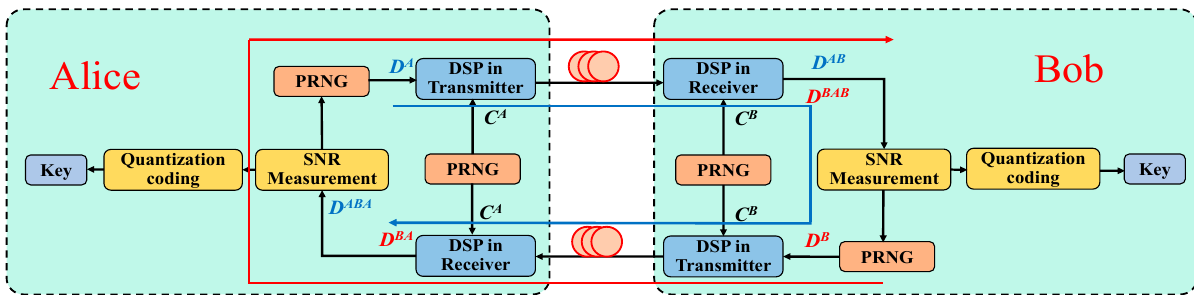
Figure 2. Schematic diagram of key generation principle at the physical layer. PRNG: pseudo-random number generator. DSP: digital signal processing.